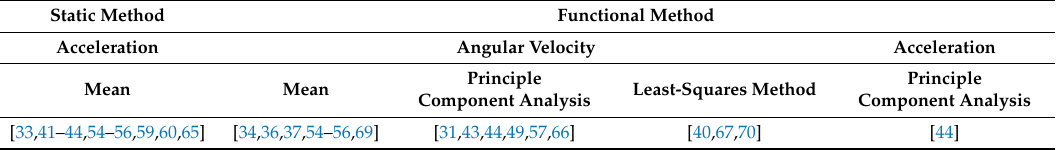
Table 2. Computations used to obtain the segment